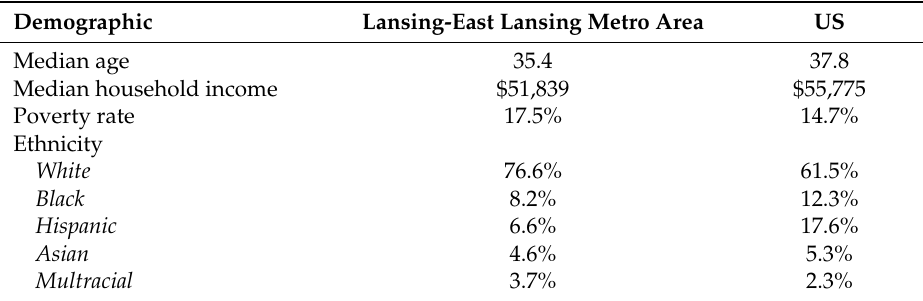
Table 1. Lansing-East Lansing, MI Metro Area (population 472,276) demographics compared to the United States, 2015 [42].